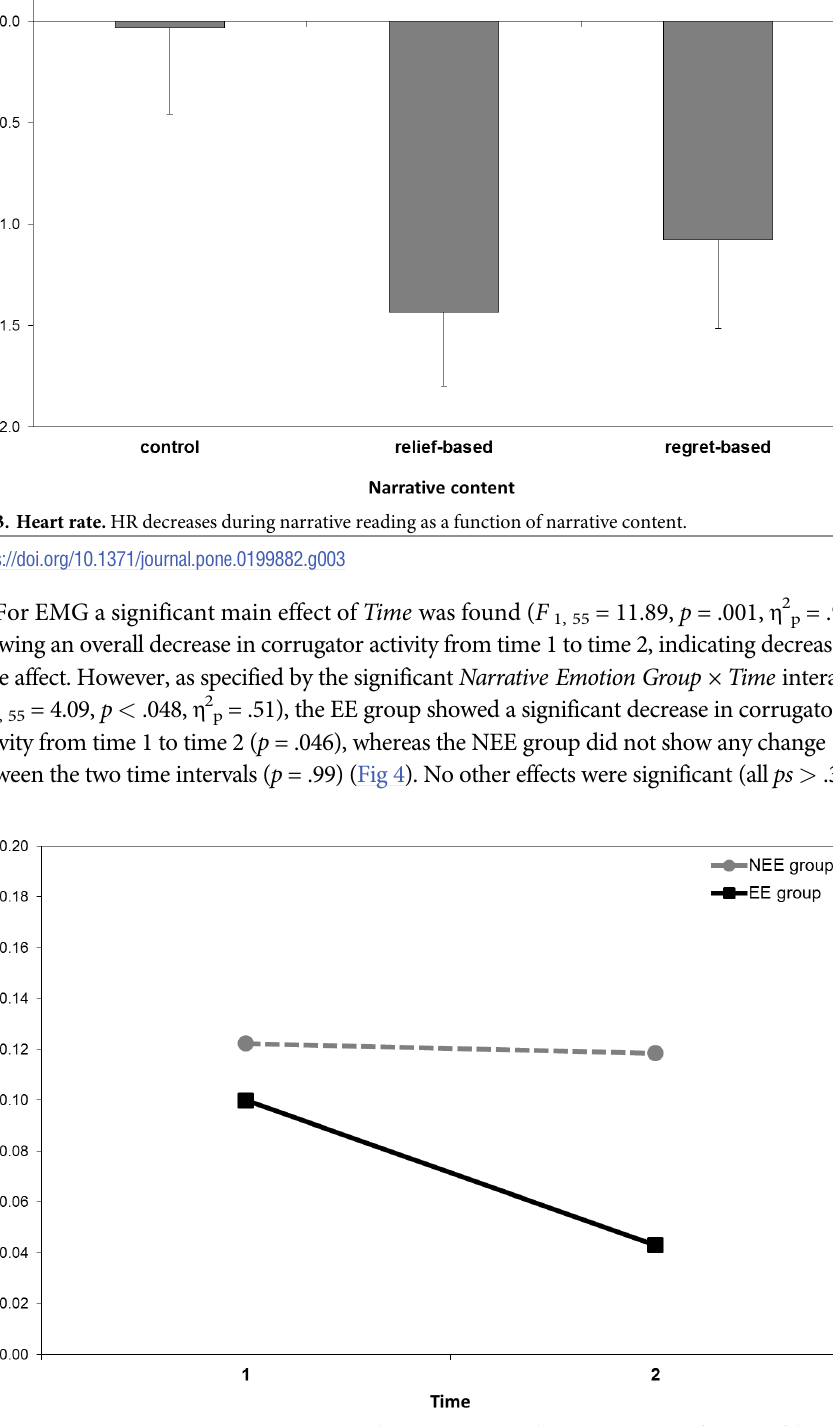
Fig 4. Corrugator EMG. Corrugator EMG activity during narrative reading across time as a function of the narrative emotion group (NEE = with no expressed emotions; EE = with expressed emotions).